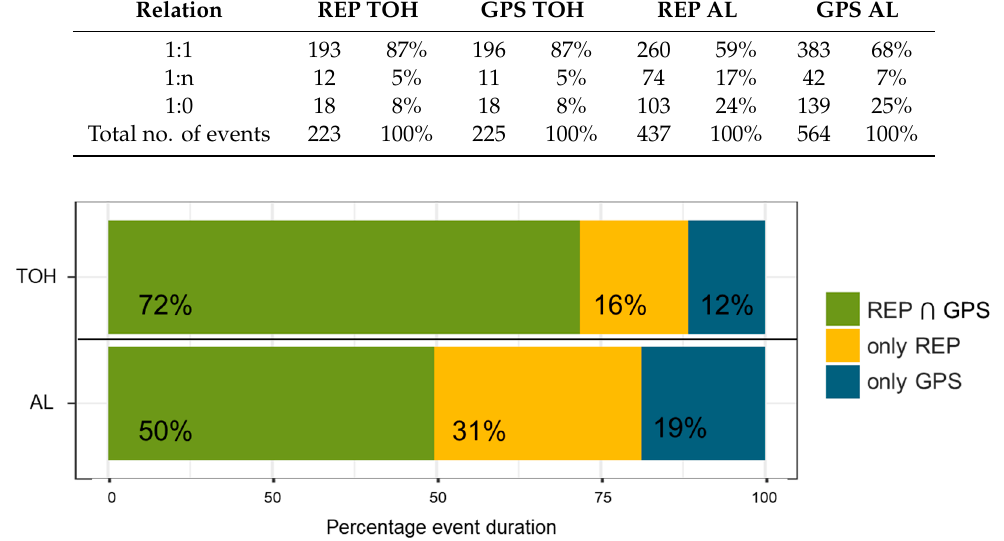
Figure 13. Percentage duration of matched, respectively, intersected (i.e., REP (cid:31) GPS), REP only, and GPS only TOH/AL events (see Figure A3 Appendix B for illustration of computation). Percentages are computed for each participant based on all valid events of all valid days and then averaged over all participants. Table 7. Measures of agreement on the level of events.